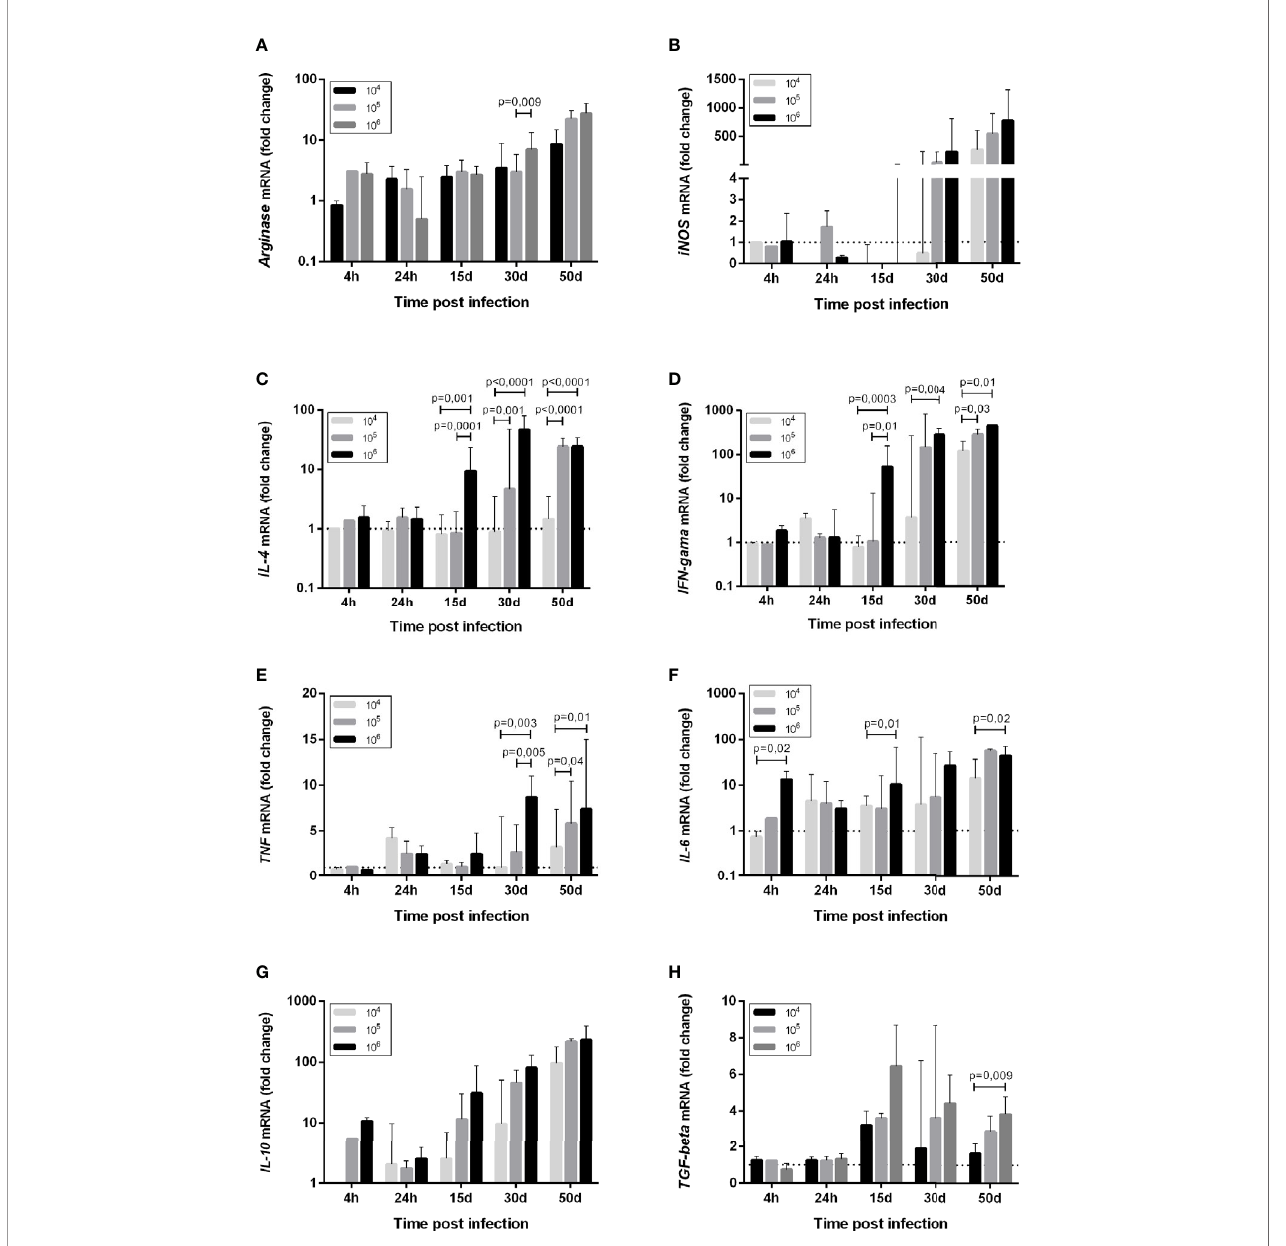
FIGURE 3 | Cytokine mRNA expression (A) Arginase , (B) iNOS , (C) IL-4 , (D) IFN-gama , (E) TNF , (F) IL-6 , (G) IL-10 , (H) TGF-beta , in the skin of golden hamsters at different time points after infection with different Leishmania ( Viannia ) braziliensis inocula. The animals were infected with three parasite concentrations (10 4 , 10 5 , 10 6 promastigotes). Skin mRNA expression was determined by RT-qPCR at different times post infection, namely the fi rst hours (4h, 24h), early (15 days and 30 days) and late (50 days) post-infection phases. The dotted line represents the basal expression of non-infected skin. The results are expressed as relative fold changes between the experimental samples and the skin of an uninfected animal, to which a p – statistical signi fi cance value 1 was arbitrarily assigned. The bar represents the median and the line, the interquartile ranges. 10 4 , 10 5 , 10 6 - number of promastigotes used for